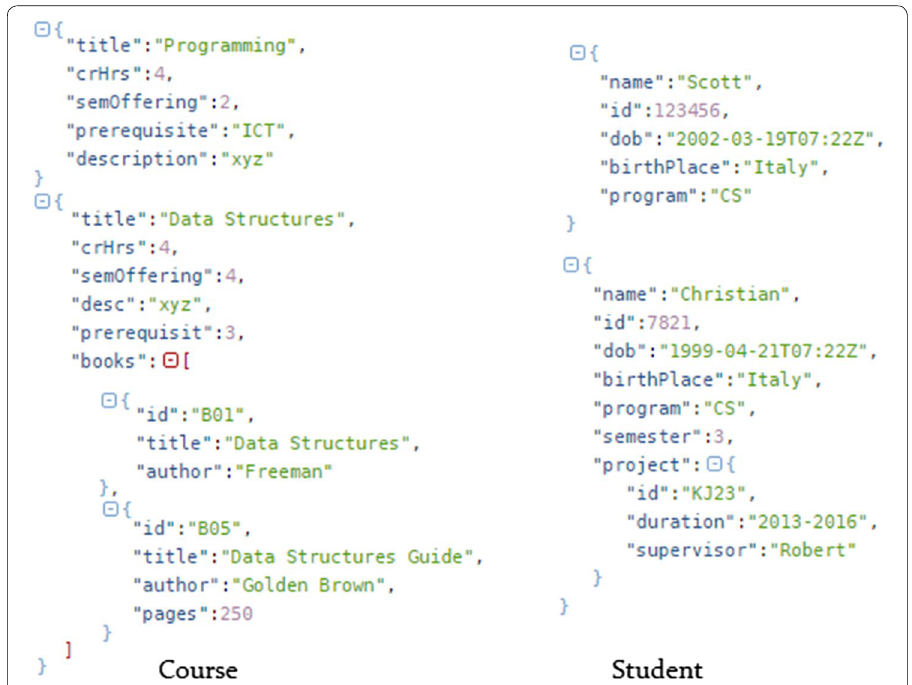
Fig. 1 Example of a documents-oriented database for the academic